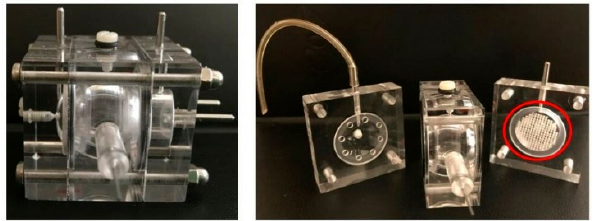
Figure 2. Ocular three-compartments flow cell developed in our laboratory with the semipermeable disk support for retinal cells (red